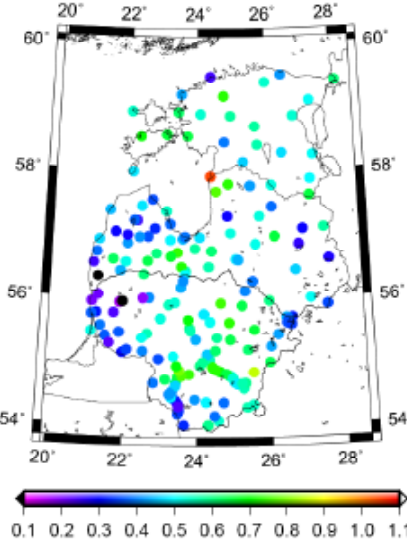
Fig. 4. Distribution of the Baltic GPS-levelling data (altogether 189points) and their differences from the EIGEN-GL04c geoidal heights (developed to n = 360). The discrepancies ( N geom – EIGEN N ) range from +0.04 to +1.04 m, with a mean of 2;360 +0.53 m. The standard deviation of the discrepancies amounts to 0.157 m. The colours of the data-points are proportional to the range of the detected discrepancies (cf. the colourbar). Unit is metre. The levellings are referred to the Kronstadt